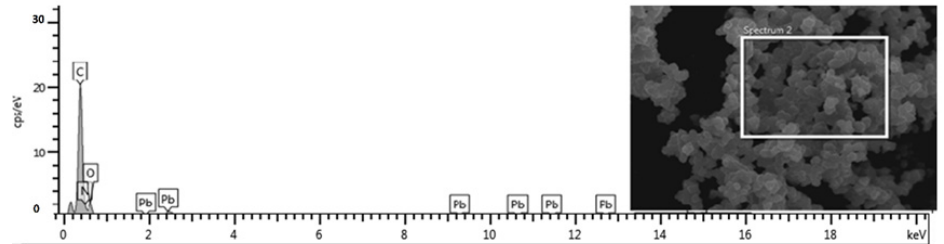
Figure 5. ( a ) TGA graph showing the thermal degradation of Ppy ‐ PEI, and ( b ) XRD graphs showing polypyrrole ‐ polyethyleneimine before and after the adsorption of lead ion. (After adsorption in red lines and before adsorption in black lines).